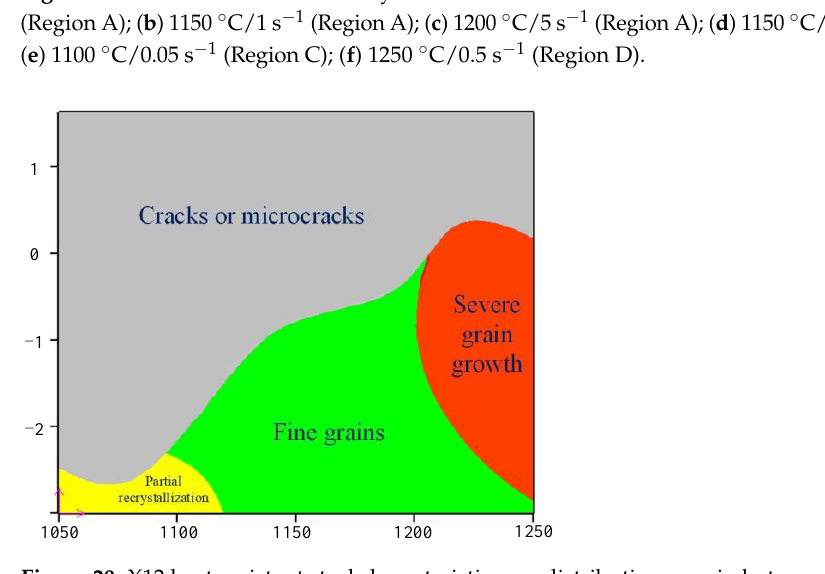
Figure 20. X12 heat-resistant steel characteristic area distribution map in hot processing map.